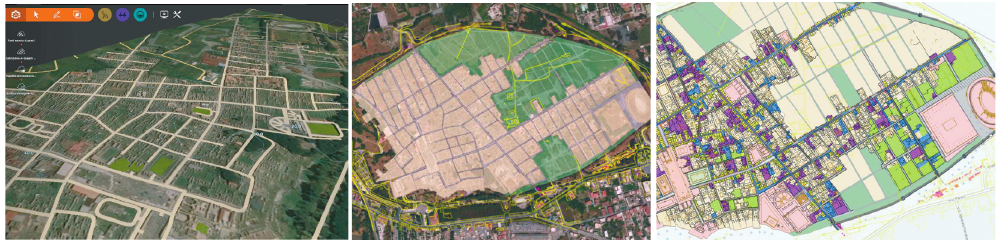
Figure 2. GIS integration in Infraworks BIM